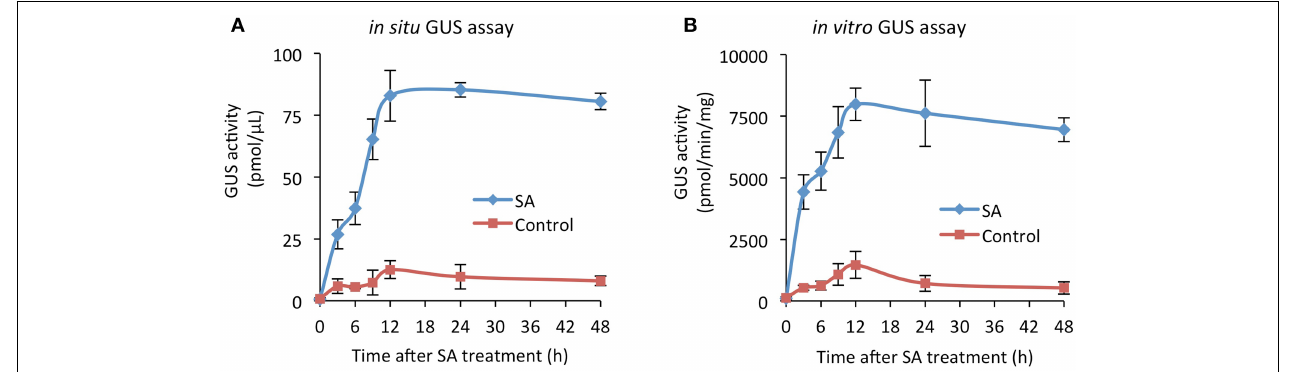
FIGURE 4 | Time course of PR1p::GUS expression upon treatment with SA. Arabidopsis seedlings harboring the SA-responsive PR1p::GUS reporter gene, grown for 12 days in liquid culture, were treated with 200 μ M SA (or 0.2% DMSO as control) for the indicated time periods. (A) GUS activity was determined with intact